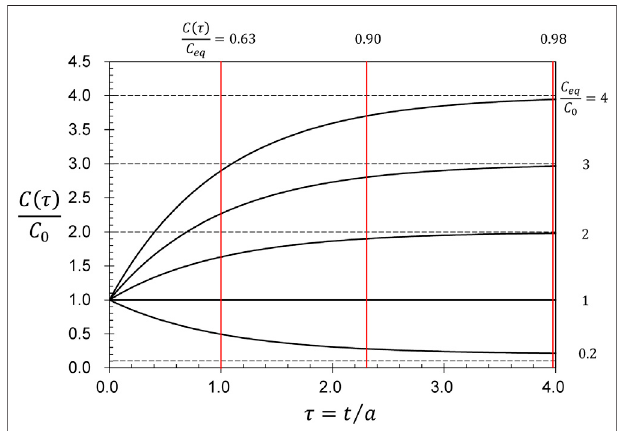
FIGURE 2 | The dimensionless concentration C ( τ ) / C 0 as a function of dimensionless time τ (cid:2) t / a , assuming C eq / C 0 (cid:2) 0.2, 1.0, 2.0, 3.0, and 4.0. Red bars show the 63, 90, and 98% response for C ( τ ) / C 0